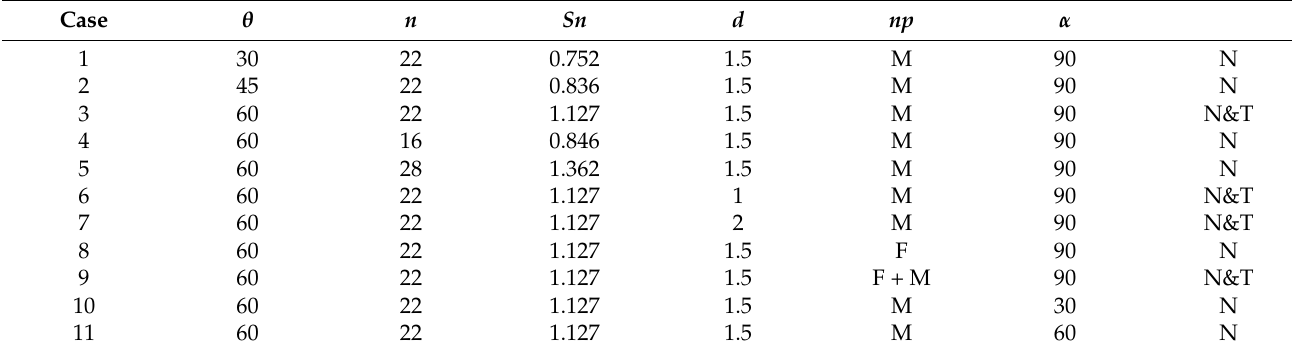
Figure 2. Combustor head with four fuel inlets and two swirlers. Table 2. The combustor structure parameters and study method.